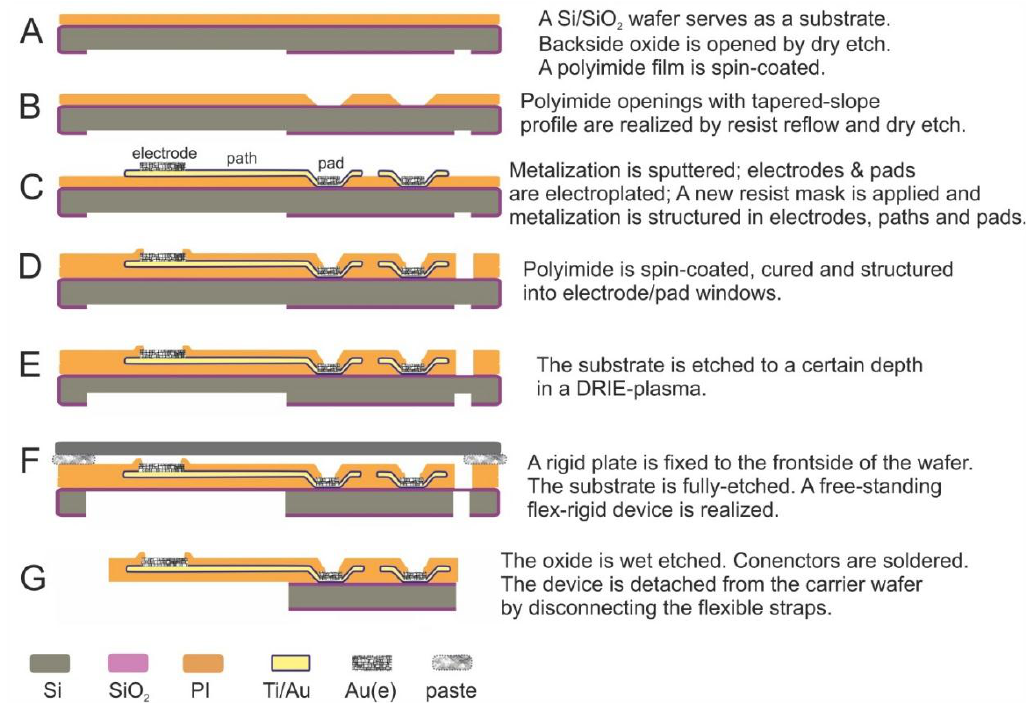
Figure 3. Microfabrication